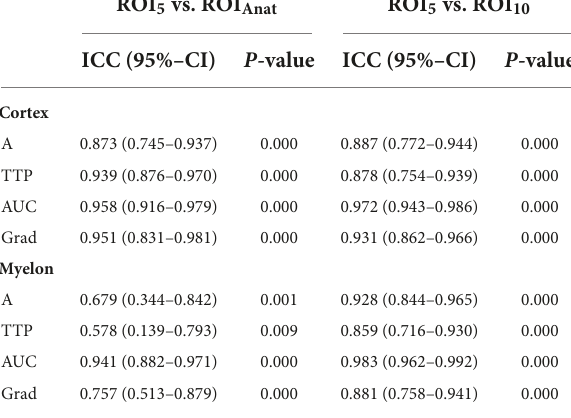
Grad and AUC in the cortex and myelon. The ICC between ROI 5 and ROI Anat decreased in the myelon for parameters A, TTP, and Grad, and if one considered not solely the IC coefficient but also the 95% confidence interval of ICC, the agreement between the two methods must be interpreted as bad ( p < 0.05). Notably, ROI 5 was the only method that measured differences between the cortex and myelon for all TIC parameters ( Tables 2–4 ).